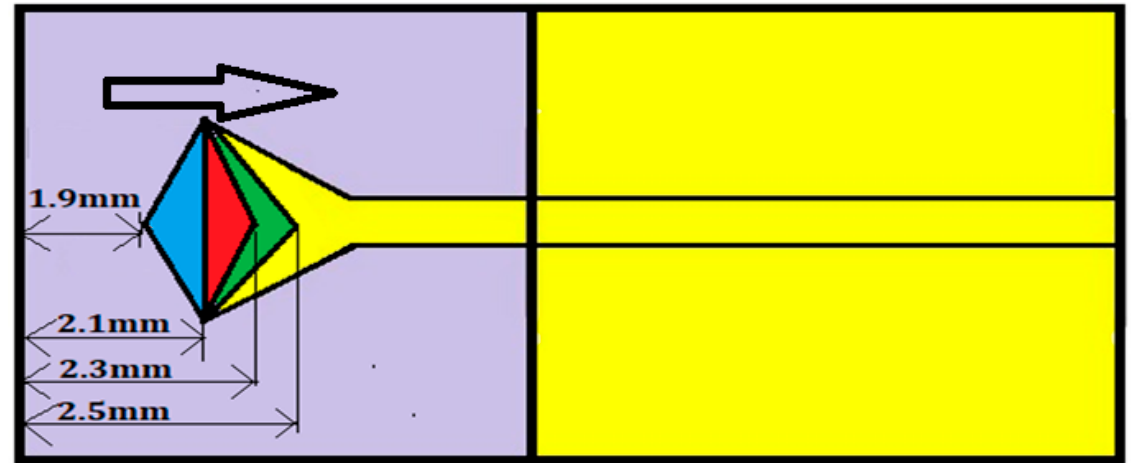
Figure 5. Fish-tail depth variations with a step size of 0.2 mm from the substrate end. Table 4. Effect of fish-tail depth variations with a fish-tail probe width W P = 3.8 mm.